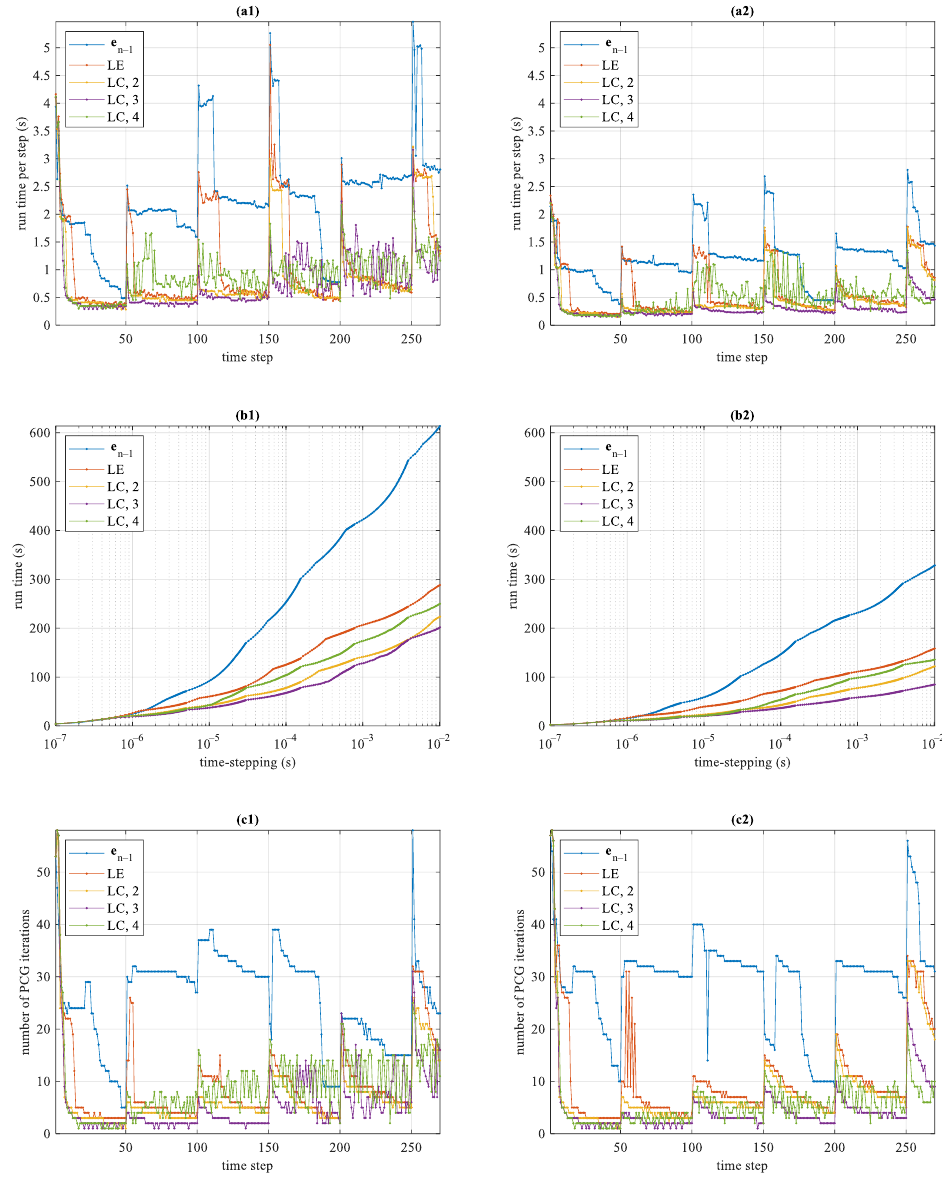
Figure 5. Example 1: efficiency comparison between SG ( left column ) and MR ( right column ) grid approaches. Abbreviations denote different initial guess ( x 0 ) approaches: (i) e n − 1 , standard approach, x 0 = e n − 1 ; (ii) LE, linearly extrapolated approach, x 0 = 2 e n − 1 − e n − 2 ; (iii) LC, N prev = 2,3,4, linearly N prev α i e n − i . Rows 1–3 show the time usage of each time step, the combined approach, x 0 = ∑ i = 1